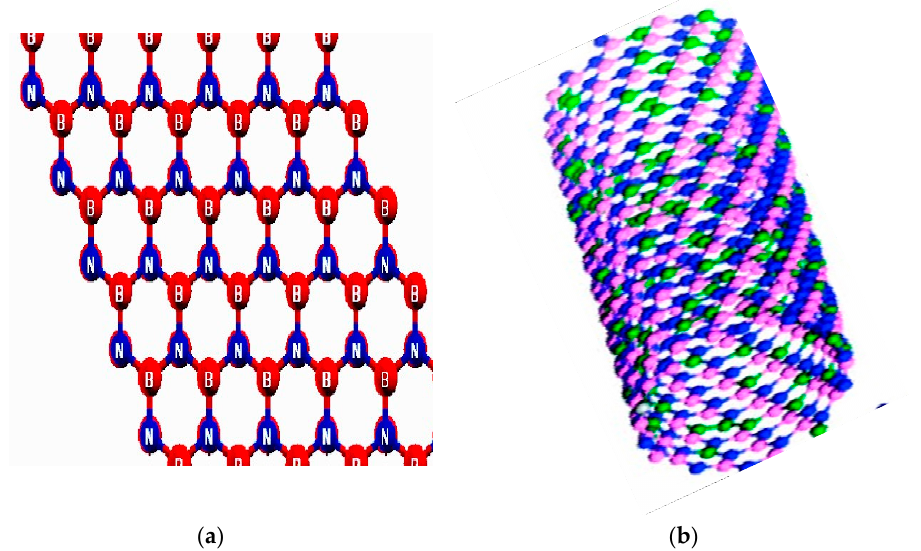
Figure 1. ( a ) h -BN sheet with boron and nitrogen atoms bonding shown ( b ) optimized structure of h -BN-CNT hetero- structures showing carbon (pink), nitrogen (green), and boron (blue)